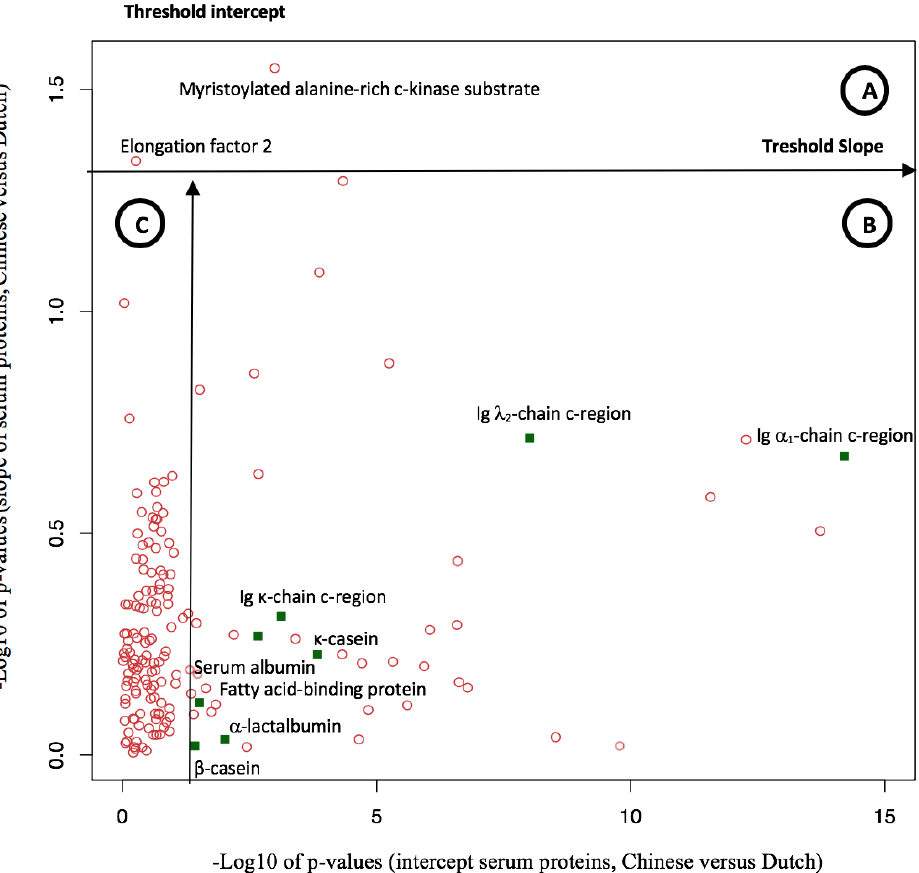
Figure 5. Comparison of the common serum proteins in Chinese and Dutch human milk during lactation. Green squares indicate the proteins displayed in Table 1. For each serum protein in Chinese and Dutch human milk over the course of lactation, a regression line was fitted, summarizing the profile for each protein into an intercept (representing week 1) and slope (representing rate of change over lactation). These profiles were used for comparison between Chinese and Dutch human milk, and the p -values for differences between them were plotted. ( A ) Significantly different proteins in Chinese and Dutch human milk over the course of lactation, based on difference in slope; ( B ) significantly different proteins in Chinese and Dutch human milk at week 1, based on intercept; and ( C ) no significant difference .